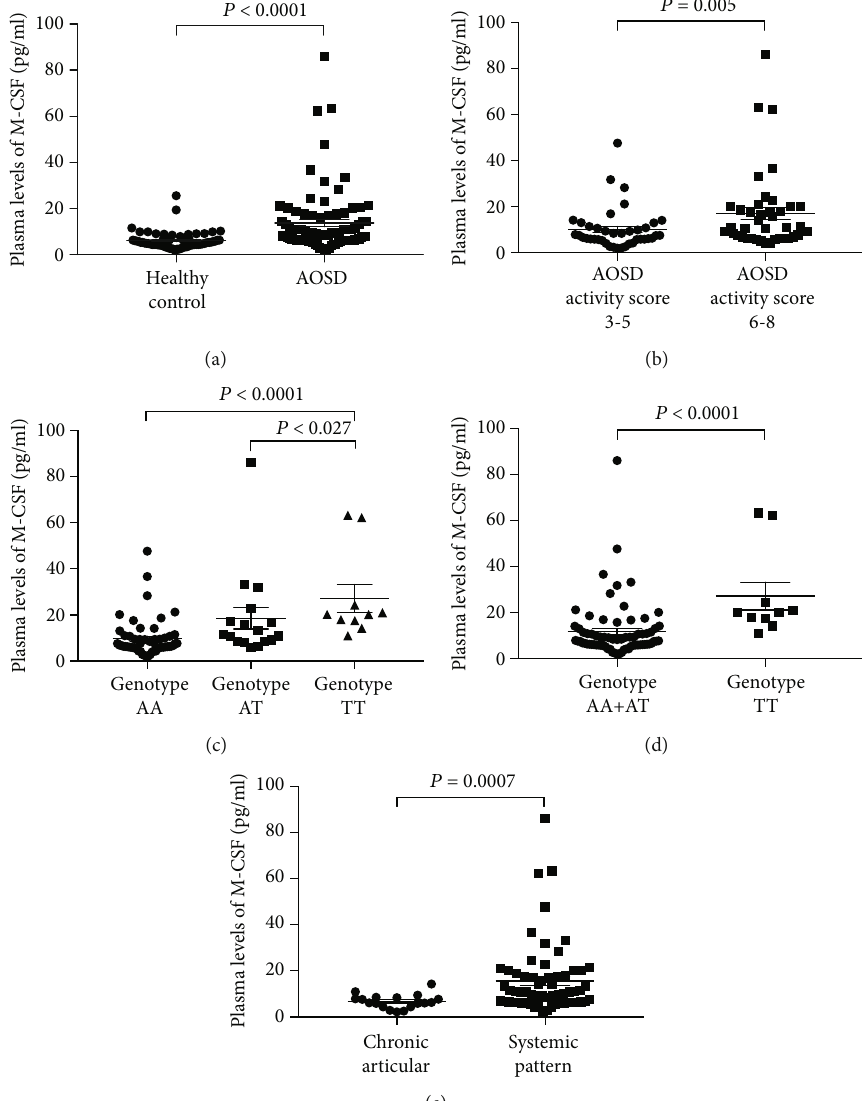
Figure 3: Increase of plasma M-CSF (macrophage colony-stimulating factor) levels in AOSD patients and correlation with the activity score, disease outcomes, and genotypes of SNP rs11102024 nearby CSF1 gene. (a, b) The plasma levels of M-CSF protein were determined in the samples of healthy controls ( n = 68 ) and AOSD patients ( n = 82 ). (a) A signi fi cant increase of plasma M-CSF levels was detected in the AOSD patients compared to those of healthy controls. (b) The plasma levels of M-CSF are signi fi cantly increased in AOSD patients with activity scores 6-8, compared to those of AOSD patients with activity scores 3-5. (c, d) The AOSD patients ( n = 82 ) were divided into three groups according to the genotype of rs11102024. (c) AOSD patients carrying the SNP rs11102024 TT genotype showed signi fi cantly higher levels of M-CSF ( n = 10 , median: 20.28pg/mL), compared to the carriers of AA genotype ( n = 55 ; median: 6.82pg/mL) ( P < 0 : 0001 ) and AT genotype ( n = 17 ; median: 11.61pg/mL) ( P = 0 : 027 ). (d) A signi fi cant increase of plasma M-CSF levels was detected in AOSD patients with rs11102024 TT genotype than those of AA/AT genotypes. (e) Correlation between the plasma levels of M-CSF and disease outcome of 82 AOSD patients (systemic pattern ( n = 64 ) and chronic articular pattern ( n = 18 )). AOSD patients with the systemic pattern showed a signi fi cant increase of M-CSF (median: 10.79pg/mL) compared to those with chronic articular pattern (median: 6.23pg/mL). These results are expressed as the mean ± SEM with each dot representing the data of an individual. Statistical analysis was performed using a two-tailed, nonparametric Mann-Whitney U